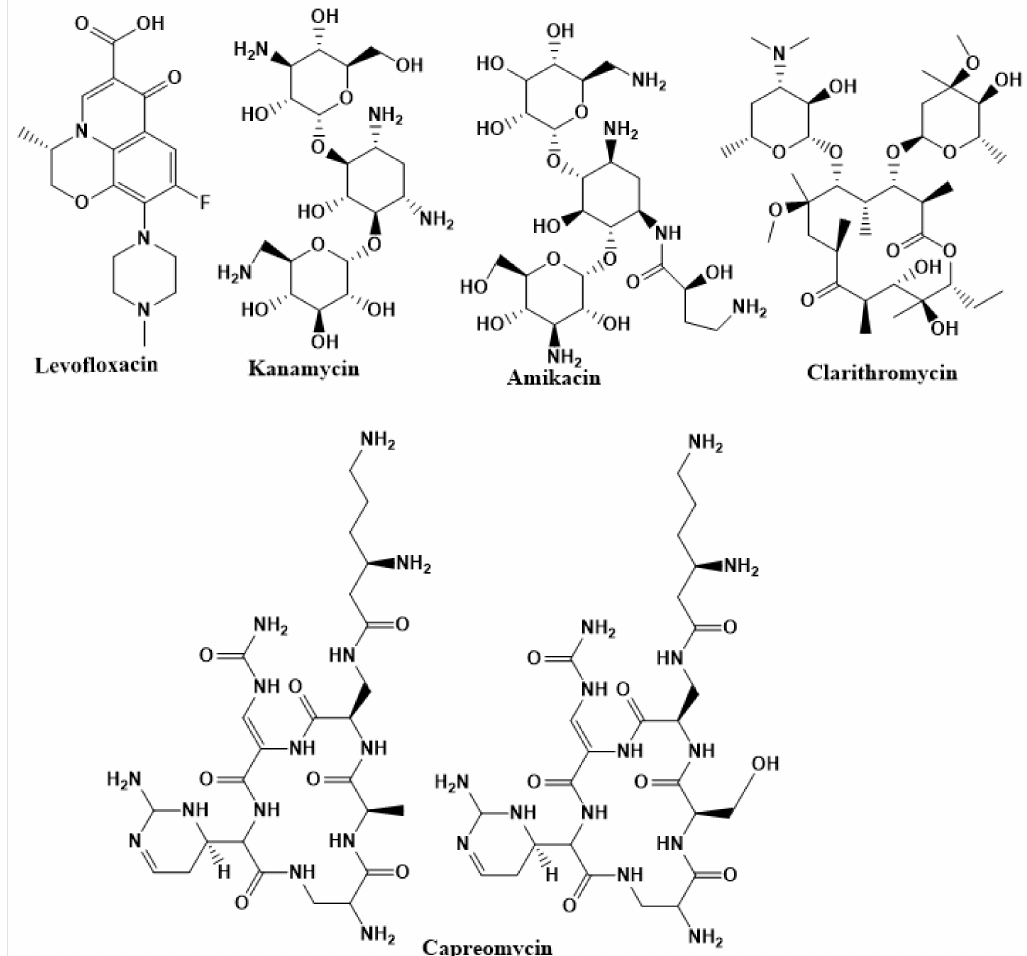
Figure 6. Chemical structures of drugs used in management of resistant